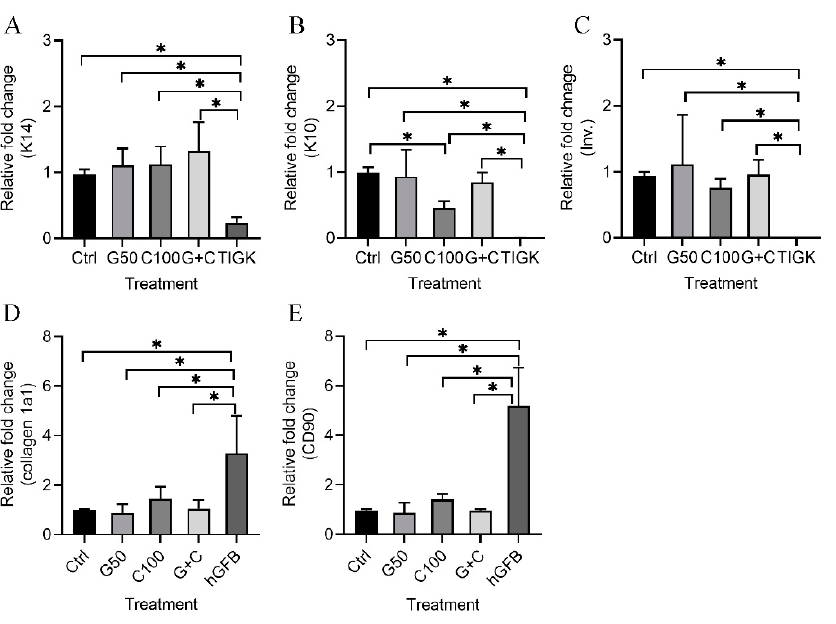
Figure 5. Quantitative RT-PCR assay [( A ) = K14, ( B ) = K10, ( C ) = Involucrin (Inv.), ( D ) = collagen 1a1 and ( E ) = CD90] of the 3D GTEs generated with the TIGKs and the hGFBs-populated collagen gels with/without genipin/cytochalasin D direct crosslinking for 2-week air–liquid interface culture. Ab- breviations: hGFBs: hTERT-immortalized gingival fibroblast; TIGKs: hTERT-immortalized gingival keratinocytes. Ctrl: control; G50: 50 µM genipin; C100: 100 nM cytochalasin D; G + C: G50 + C100. *: p < 0.05.